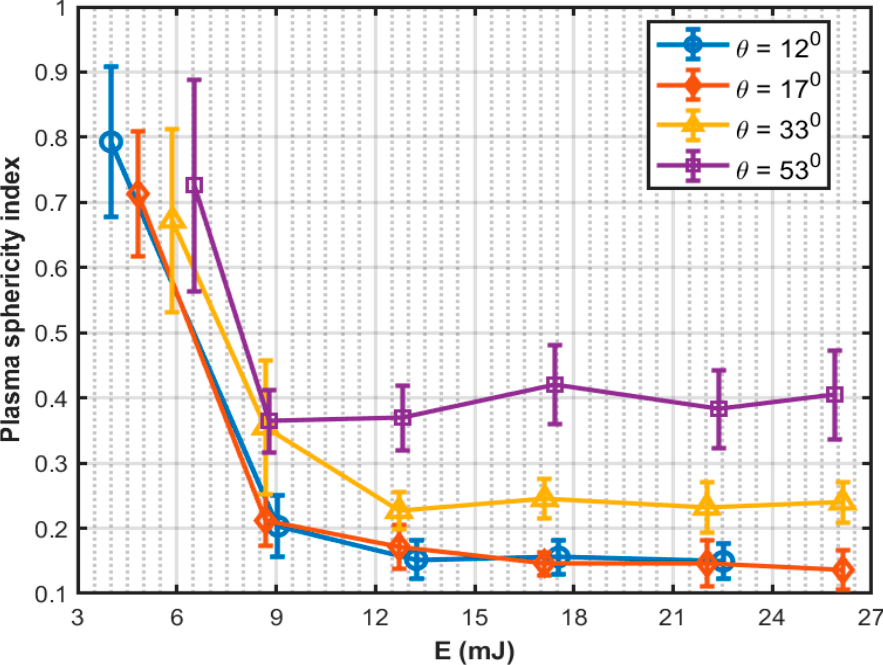
Figure 3. Plasma sphericity index with laser pulse energy and focusing angle, redrawn from [62].